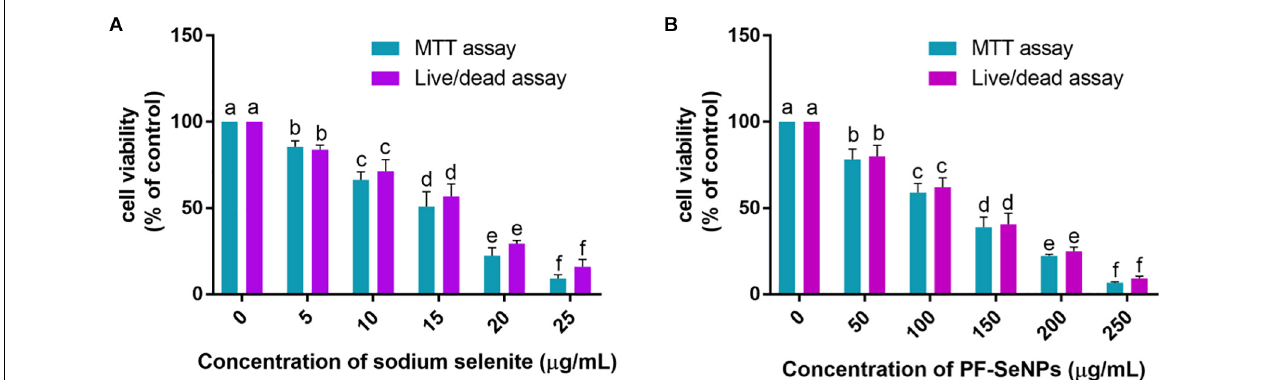
FIGURE 8 | Determination of dose-dependent inhibitory effect of (A) sodium selenite and (B) phytofabricated selenium nanoparticles (PF-SeNPs) on cell viability of N2a cells for 24 h by MTT and live/dead dual staining assays. The experiments were executed independently in triplicates and data was expressed as mean ± SD. The statistical difference between the test samples were assessed by Tukey’s multiple comparison test and p ≤ 0.05 was considered as a significant. The bar graphs with different alphabetic letters within the respective study were significant.